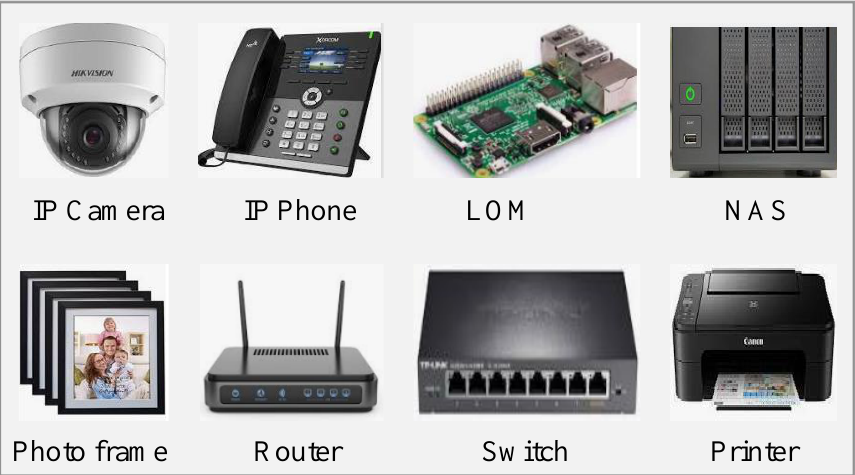
Figure 3. Embedded devices used in web-based management